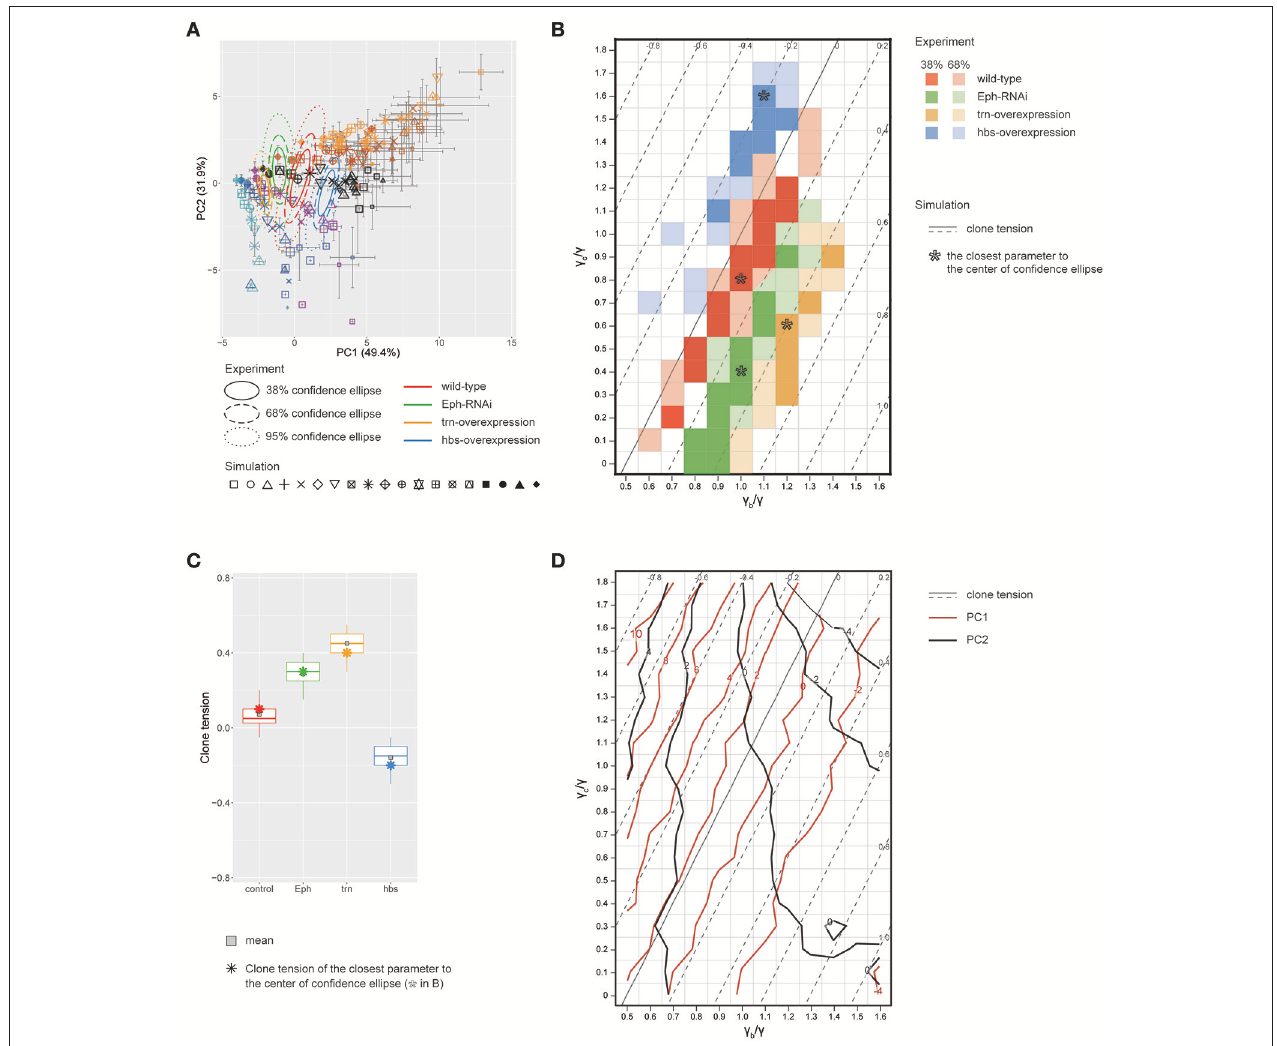
FIGURE 5 | Inference of tension parameter and clone tension of four genotypes. (A) Projection of simulated clones onto the PC space of Drosophila experiments (See Section Projection of the Simulation Data onto the PCA Space of the Experimental Data for Projection; Symbols denote parameter values given in Figure 4B ). A limited set of simulation points are plotted for visibility (see Supplementary Figure S12 for the projection of the entire simulated dataset). The experimental confidence ellipses were identical to those in Figure 3H . The averaged PC scores were plotted with symbol size proportional to the number of cells within a clone and error bar representing standard deviation. (B) Estimated mechanical parameters of four genotypes. Mechanical parameters within the 38 and 68% confidence ellipses in (A) are shown by dark and light colors, respectively. Pentagon asterisks (*) mark the best representative parameters, which are the closest to the center of each confidence ellipse. (C) Estimated clone tension of four genotypes calculated by the estimated mechanical parameters within the 68% confidence ellipse [dark and light colors in (B) ]. The upper/lower hinge and thick middle line represent the 25th/75th and 50th percentiles, respectively. Gray squares show the averaged clone tension. Octagonal asterisks are the clone tension of the best representative parameters [pentagonal asterisks in (B) ]. (D) Projection of the contour lines of PC1 and PC2 scores onto the parameter space of vertex model simulations.